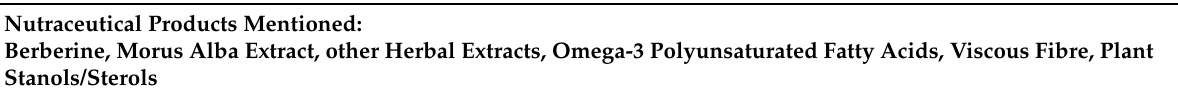
Table 3. Nutraceutical products and guidelines for type 2 diabetes